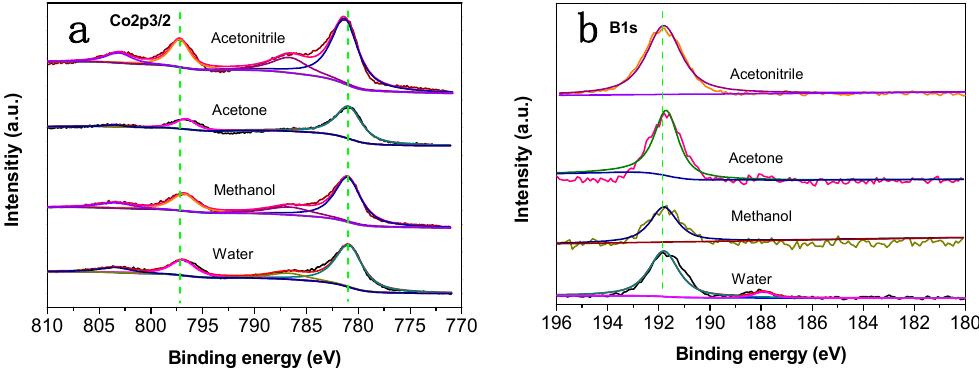
Figure 4. XPS (X-ray photoelectron spectroscopy) spectra of the ( a ) Co 2p 3/2 and ( b ) B 1s levels of Co–